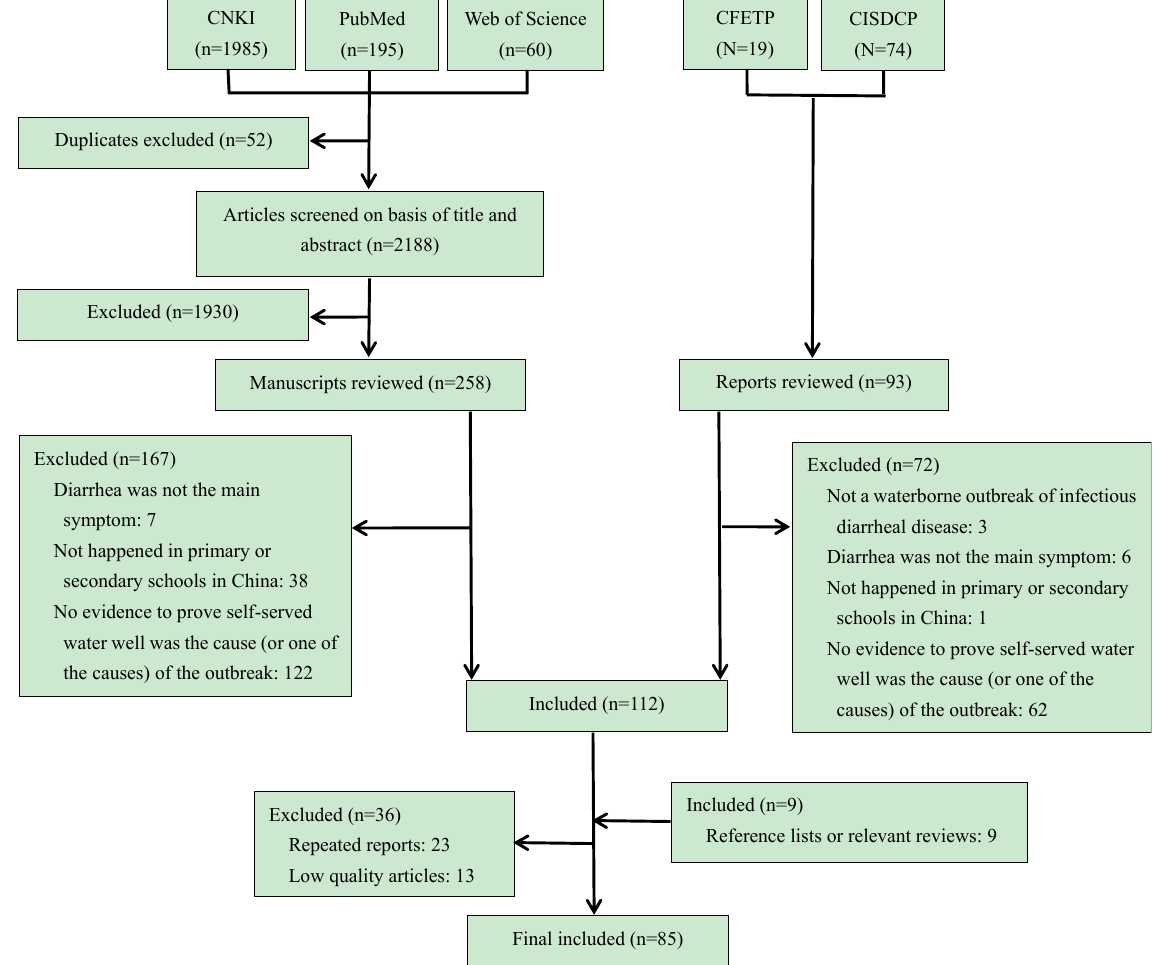
Fig.1. Flow diagram of study selection. CFETP: Chinese Field Epidemiology Training Program; CISDCP: China Information System for Disease Control and Prevention; CNKI, China National Knowledge